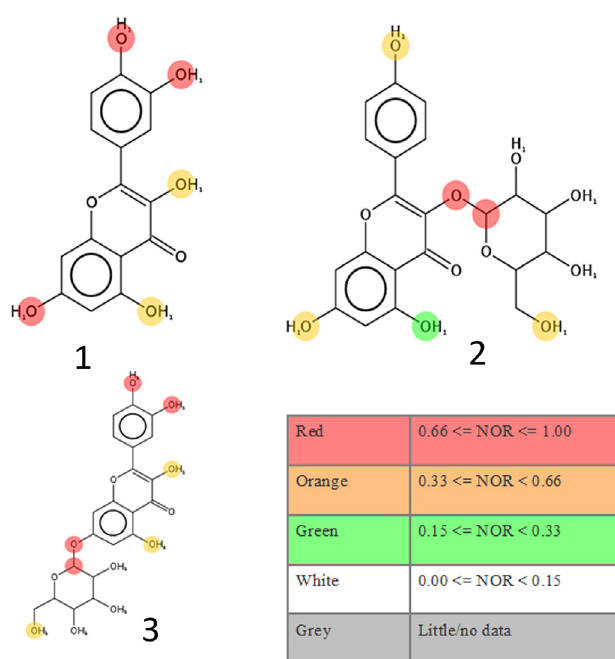
FIGURE 2 - Metabolic transformations of (1) quercetin, (2) astragalin and (3) quercetin